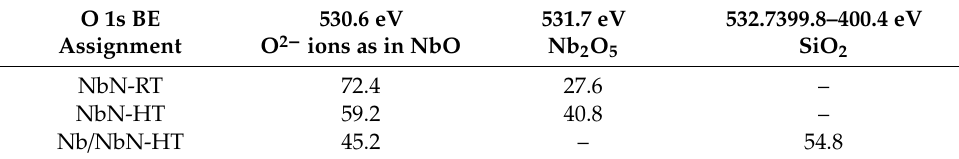
Table 7. XPS curve-fitting results of O 1s spectra (total peak area = 100%).